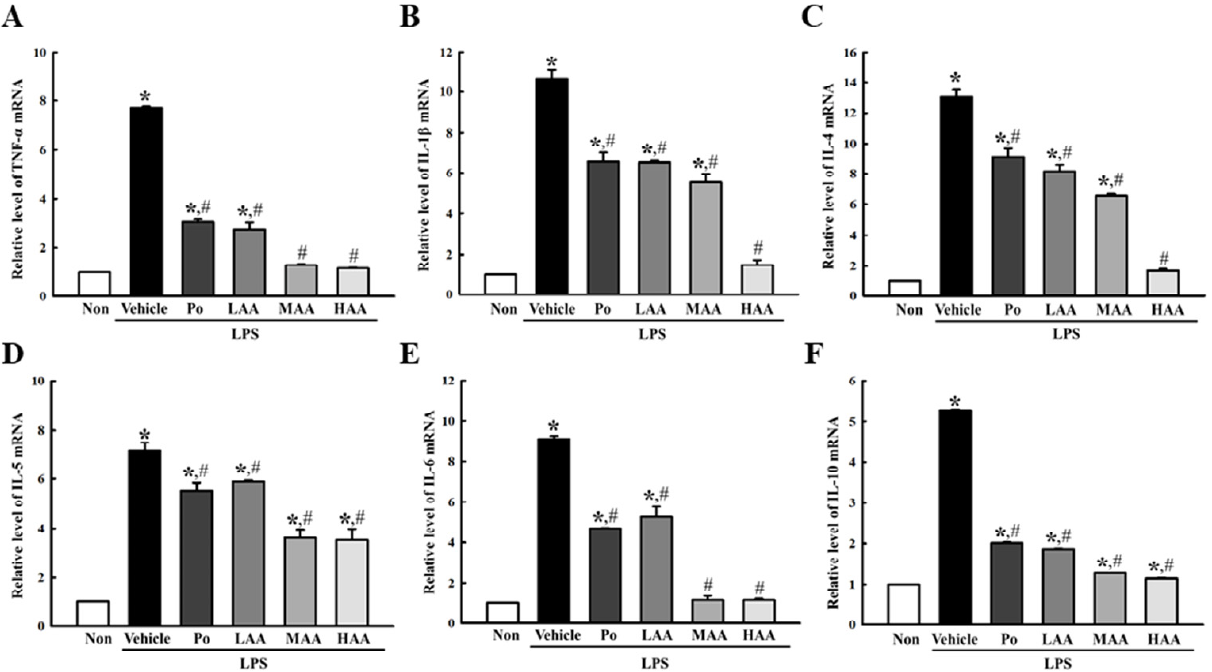
Figure 5. Level of inflammatory cytokines in RAW264.7 cells treated with AA. The levels of ( A ) TNF- α , ( B ) IL-1 β , ( C ) IL-4, ( D ) IL-5, ( E ) IL-6, and ( F ) IL-10 transcripts were measured in the total mRNA of AA+LPS-treated RAW264.7 cells by RT-qPCR using specific primers. The mRNA levels of the six genes were calculated based on the intensity of β -actin as an endogenous control. The total RNAs were added to three to five wells per group, and RT-qPCR analyses for each sample were analyzed in duplicate. All values in the results are represented as the means ± standard deviation (SD). * indicates statically significance compared to the non-treated group, while # indicates stati- cally significance compared to the Vehicle+LPS-treated group. Abbreviations: AA, abietic acid; LPS,